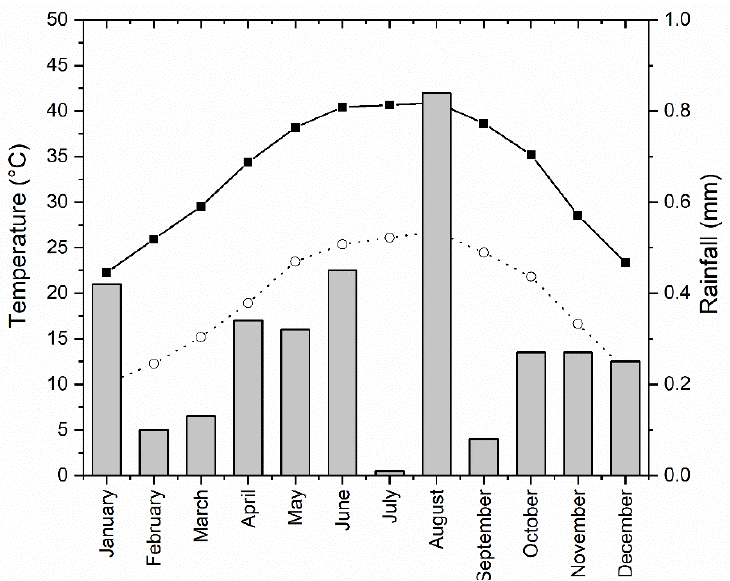
Figure 8. Monthly averages of temperature (°C), rainfall, and relative humidity of Aswan through the last ten years (2009–2019).